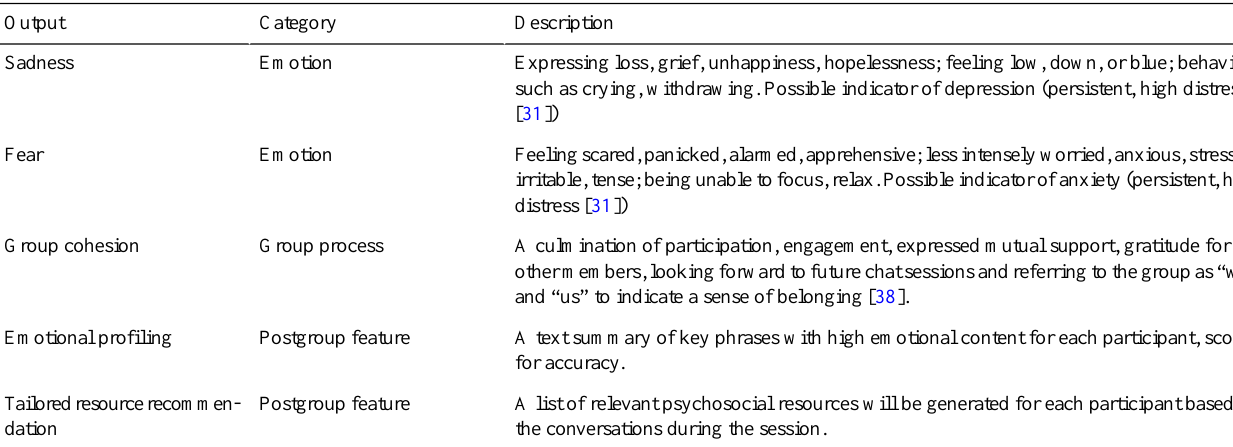
Table 2. Target measures for human